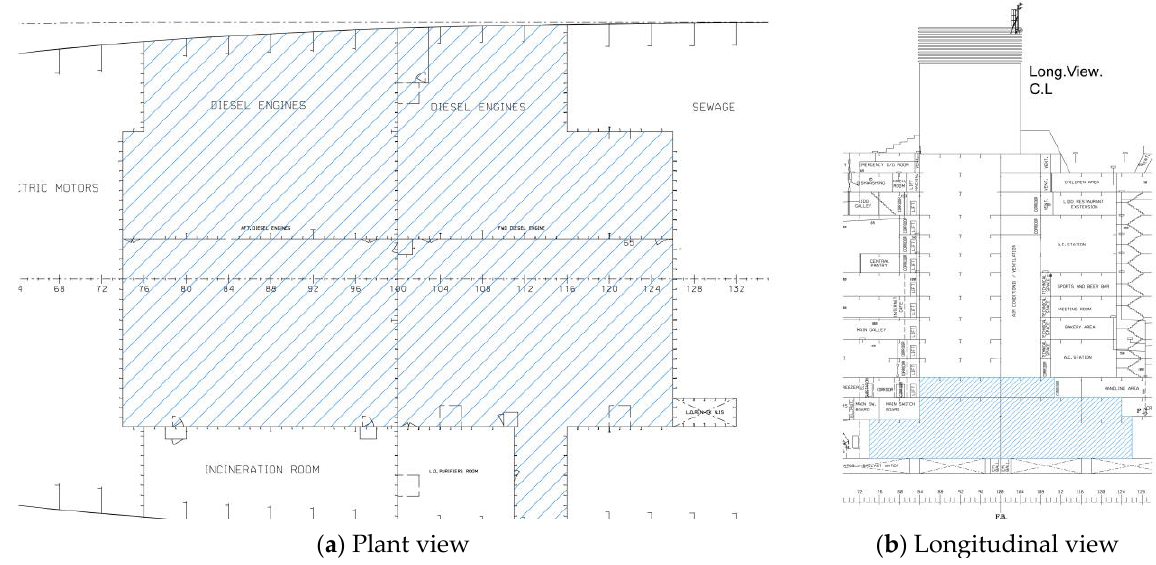
Figure 8. Spaces for the allocation of the fuel cell moduli, the fuel system, and batteries.